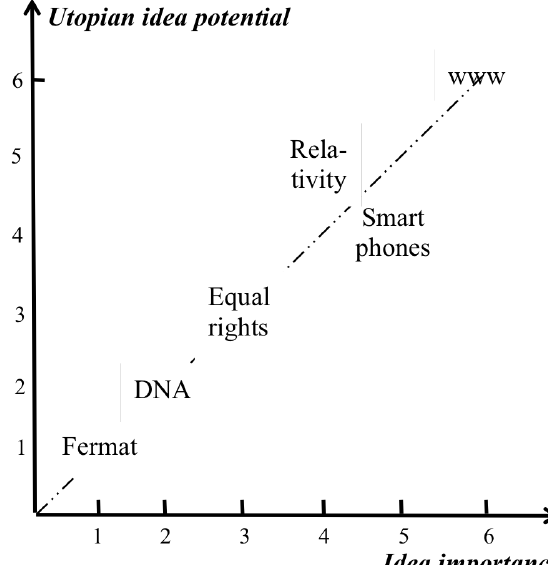
Fig. 4. The graph shows the utopian potential ranking as a function of idea importance ranking with data from Tables 1 and